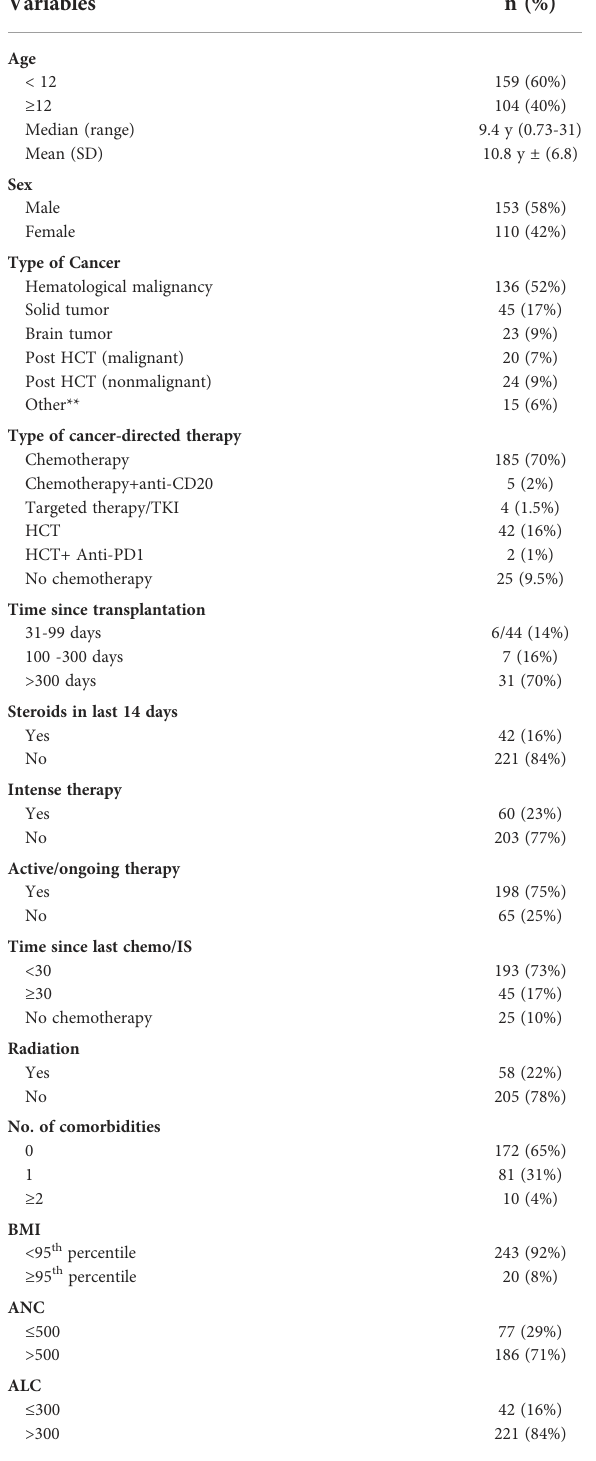
*n=263 patients with COVID-19 infection ** Other: Inherited bone marrow failure syndrome (IBMF), Idiopathic severe aplastic anemia (SAA), hemoglobinopathies (Thalassemia, sickle cell disease, Hereditary spherocytosis), Histiocytic disorder (LCH), systemic juvenile idiopathic arthritis standard deviation